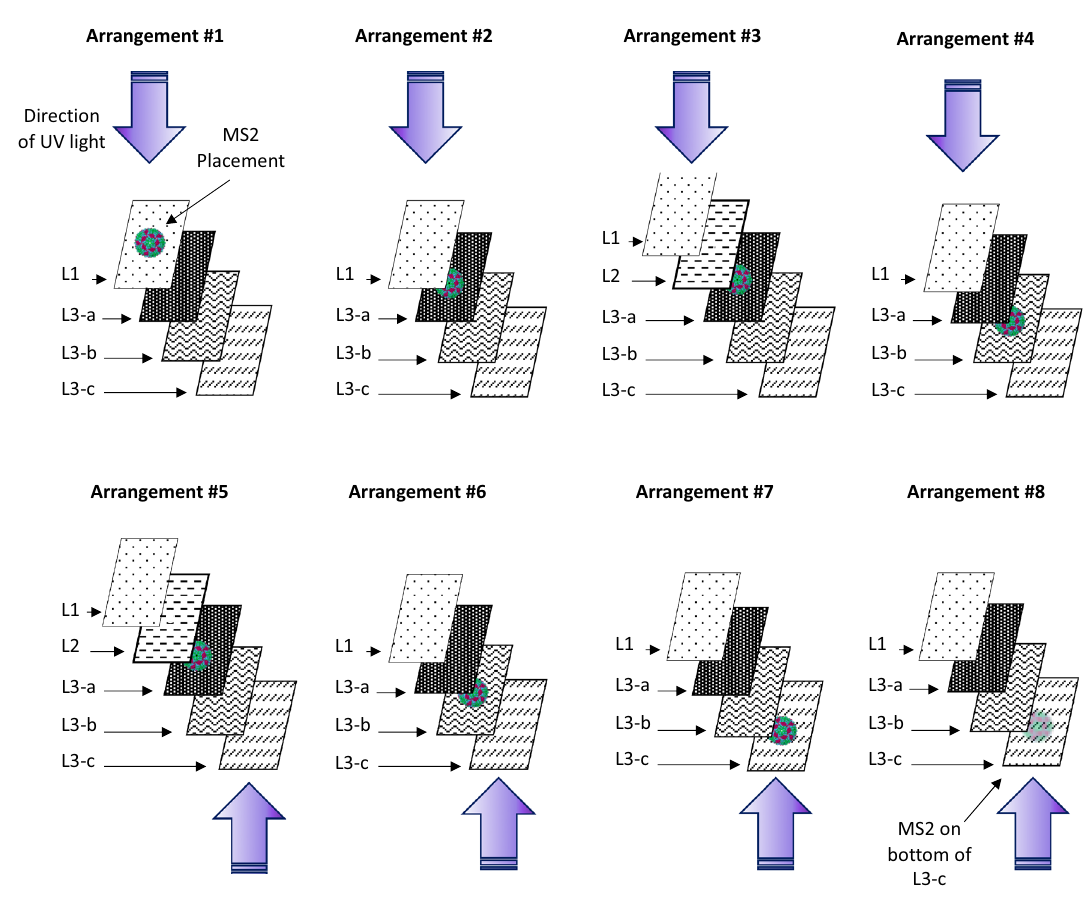
Figure 2. Inter-layer inoculation and UV exposure arrangements. Arrangements 1, 2, 4, and 6–8 represent the upper section of the 9210 FFR (comprised of L1 and L3). Arrangements 3 and 5 represent the front of the FFR (comprised of L1, L2, and